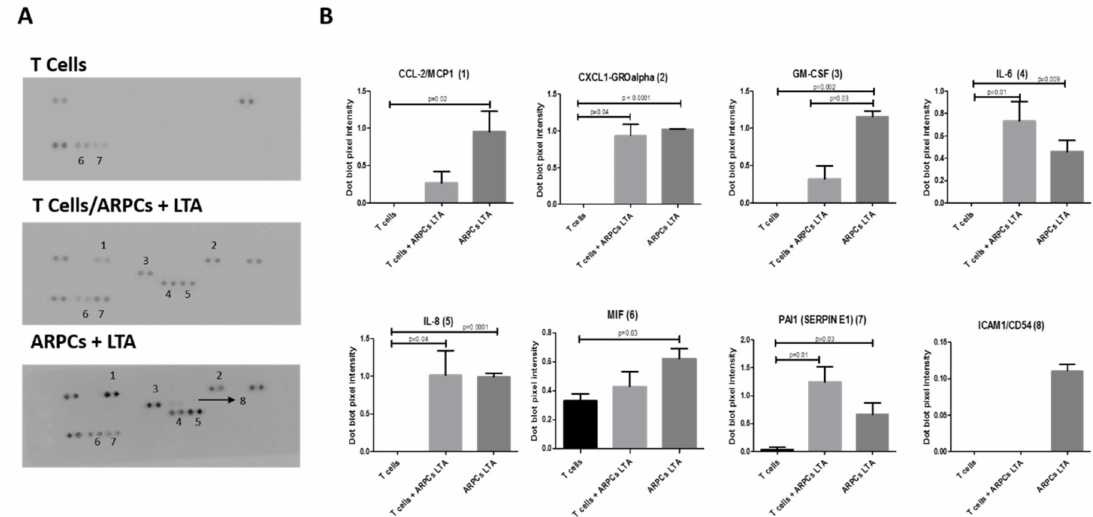
Figure 5. Activated ARPCs secreted a specific pattern of cytokines. The Human Cytokine Array detects 36 human cytokines in cell culture supernatants. The arrows and numbers indicate the cytokine array dot blots. ( A ) Dot blot pixel intensity is graphed. ( B ) Data are representative of three independent experiments (means ±